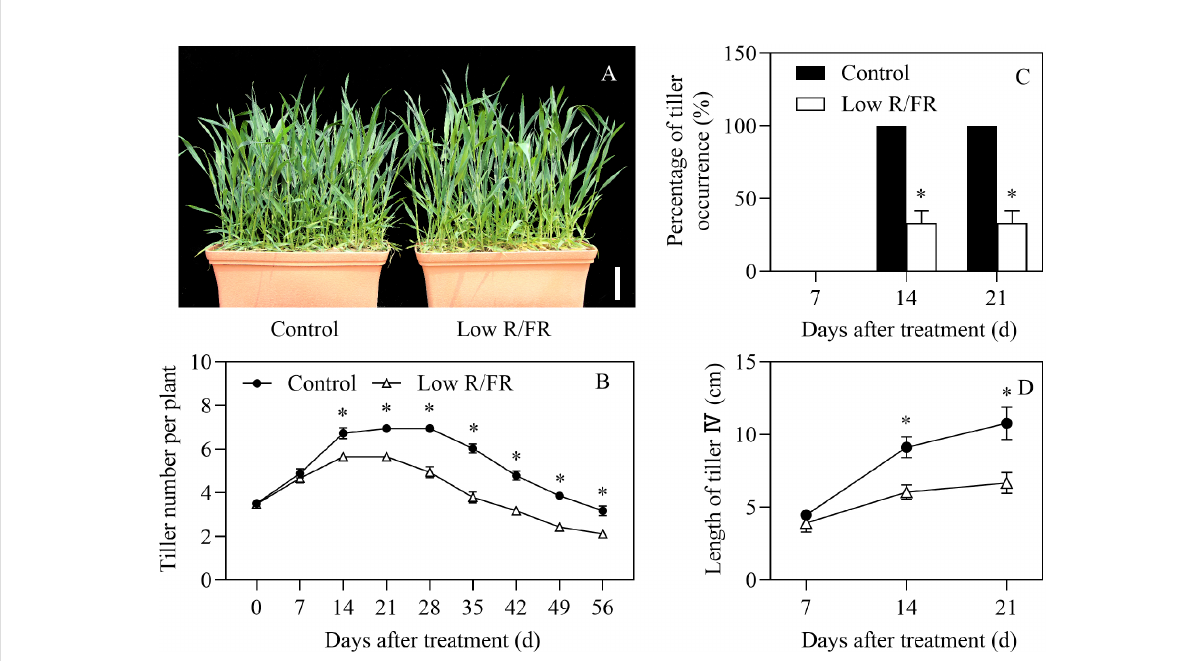
FIGURE 1 Plants and tillers phenotype under control and low R/FR conditions. (A) Comparison of phenotype at booting stage (56 DAT), and the white legend represents 10 cm. (B) Tiller number per plant was tested at 0, 7, 14, 21, 28, 35, 42, 49 and 56 DAT. (C) The percentage of tiller occurrence of tiller IV was counted at 7, 14 and 21 DAT. Tiller IV means the tiller bud from the axil of the 4 th leaf from bottom on the main stem. (D) Length of tiller IV was determined at 7, 14 and 21 DAT. Data are the means of three biological replicates ± SE, and the asterisk denotes a statistically remarkable difference ( P < 0.05) between treated and control samples. DAT, days after